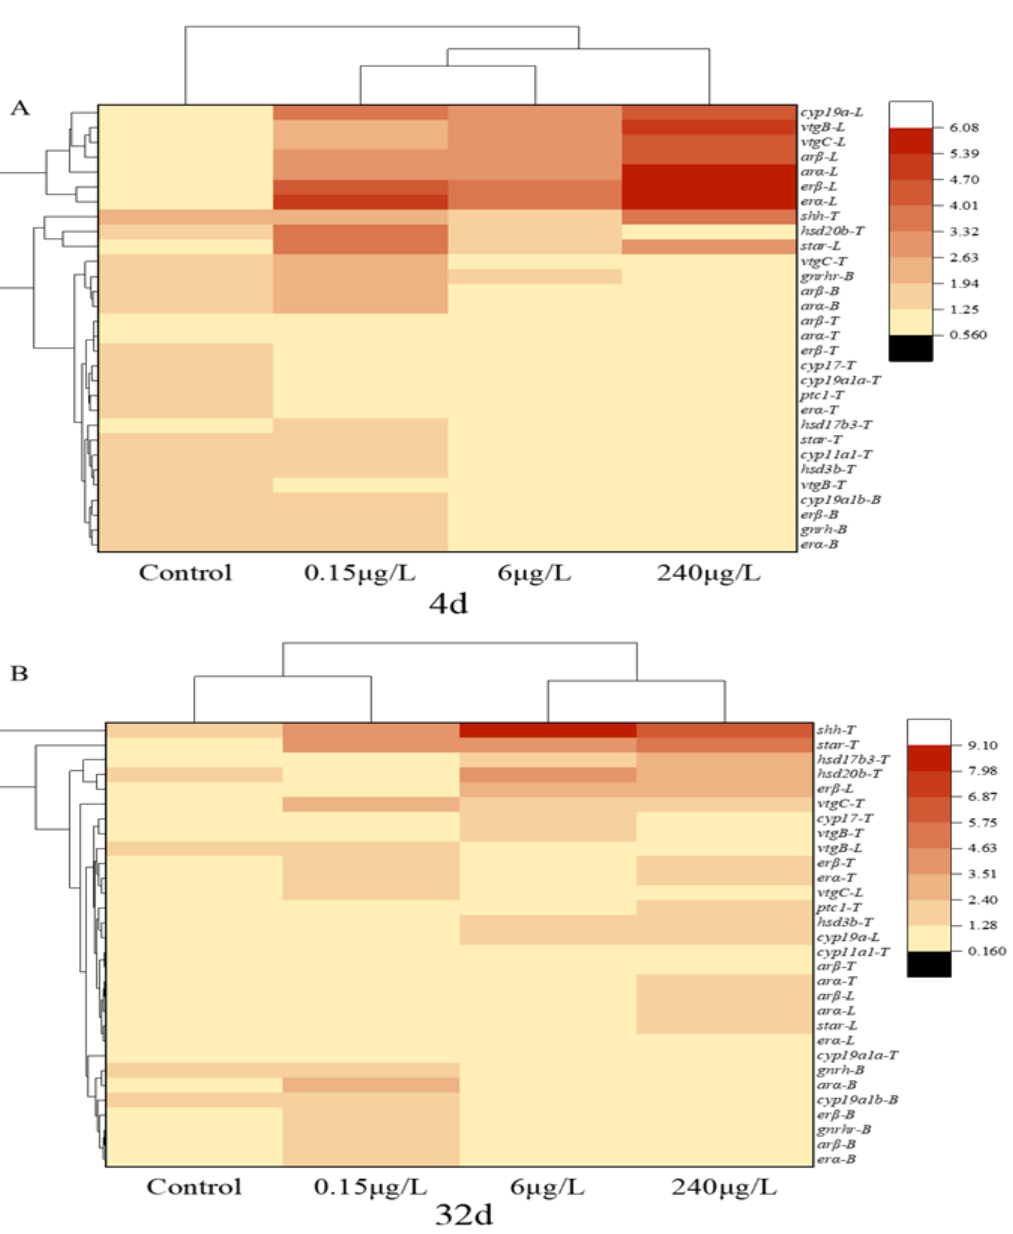
Figure 5. Hierarchical clustering analysis of qPCR data of the male mosquitofish suffered from 0, 0.15, 6, 240 μg/L PrP for 4d ( A ) and 32d ( B ). Abbreviations: B, brain; L, liver; T, testes; other abbreviations for the genes were the same as mentioned above.